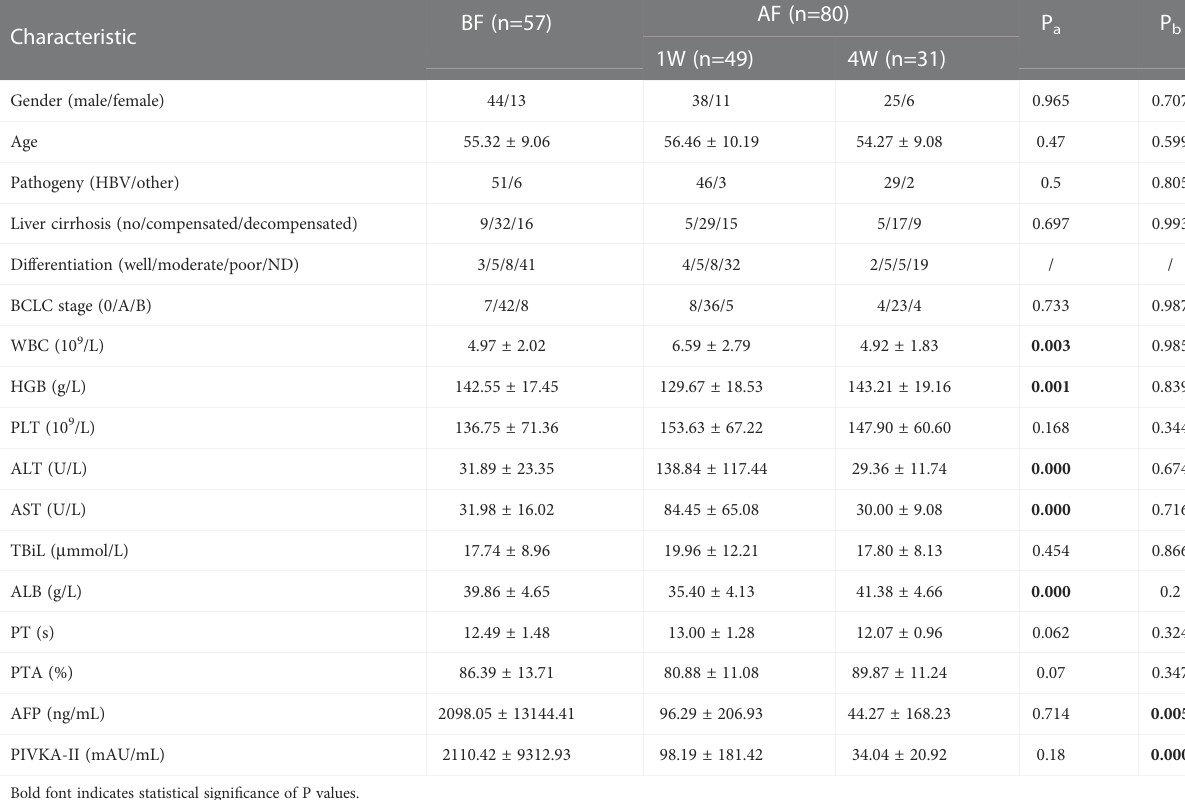
TABLE 2A Characteristics of enrolled individuals without VI/M and achieved curative therapy before and after ablation.